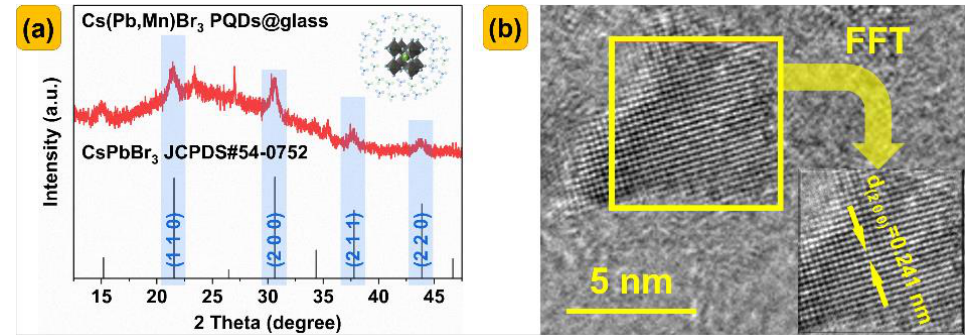
Figure 2. ( a ) XRD patterns of Cs(Pb 0.9 Mn 0.1 )Br 3 PQDS@glasses, and also the standard cubic crystal structure of CsPbBr 3 (JCPDS#54 − 0752). The internal picture shows the Cs(Pb,Mn)Br 3 nanocrystals precipitated from glasses. ( b ) HRTEM images of Cs(Pb 0.7 Mn 0.3 )Br 3 PQDS@glasses.